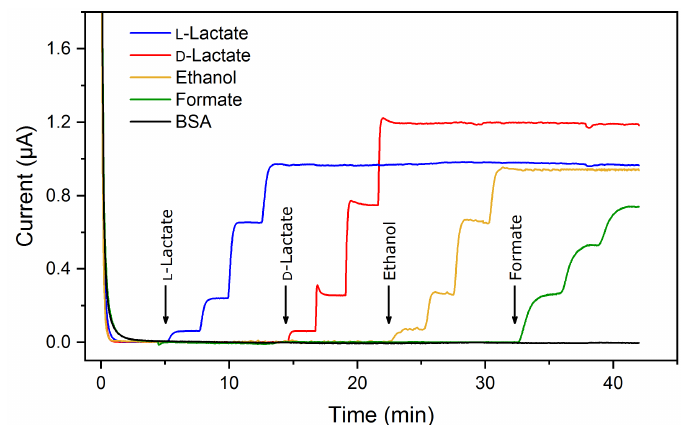
Figure 3. Chronoamperometric current responses of the multi-analyte biosensor to successive addition of single analyte stock solutions ( L -lactate, D -lactate, ethanol, and formate) in 100 mM potassium phosphate buffer (pH 7.5). A working electrode with immobilized bovine serum albumin (BSA) served as a blank